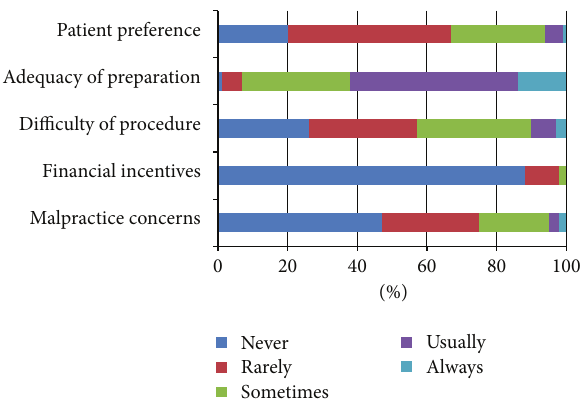
Figure 3: Please rate how often do you shorten a surveillance rec- ommendation compared to the guidelines based on the following factors ...